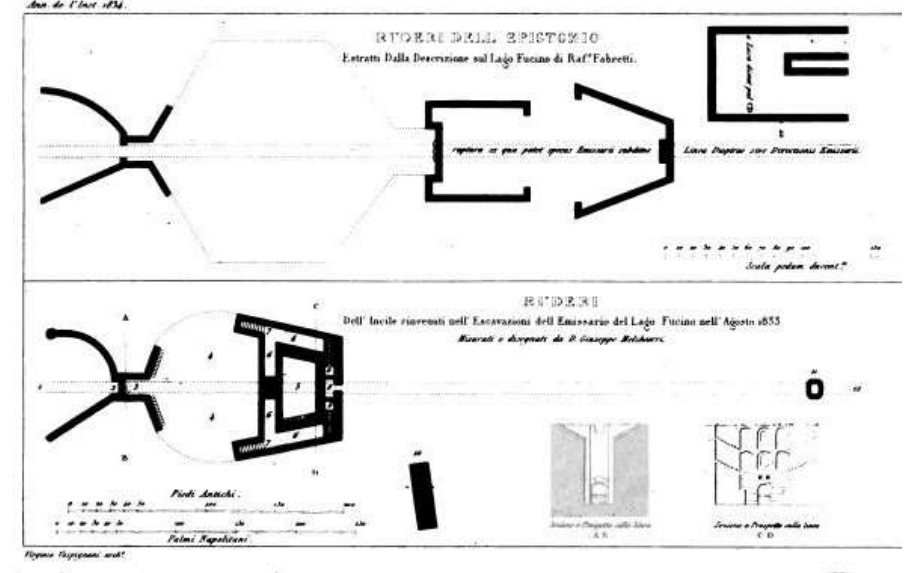
Figure 6. Annali dell’Istituto di Corrispondenza 1834, G. Melchiorri plan and front of the Roman incile.